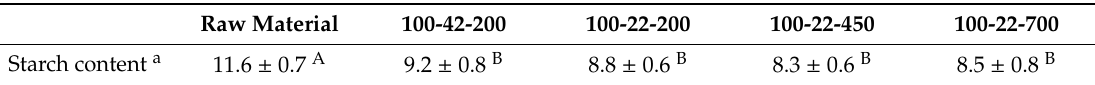
Table A4. Starch contents (g / 100 g dry matter) of raw and extruded apple pomace (mean value ± standard deviation, n = 3).